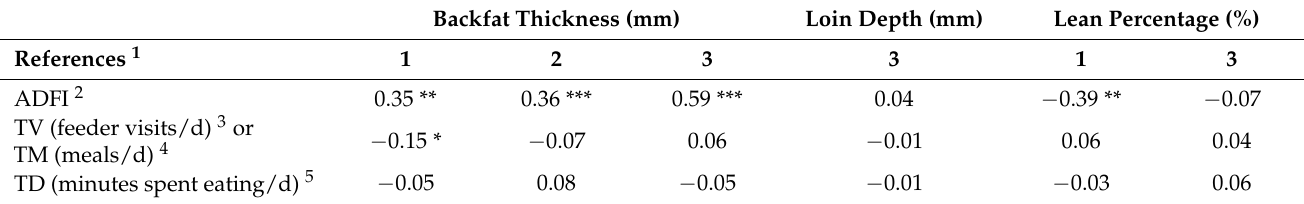
Table 9. Correlation results between feeding behaviour habits and carcass quality obtained by different